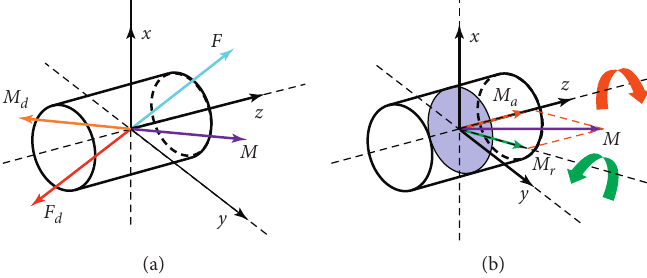
Figure 2: The force and torque at the joint. (a) The torque and force at the joint. (b) The decomposition of torque M .